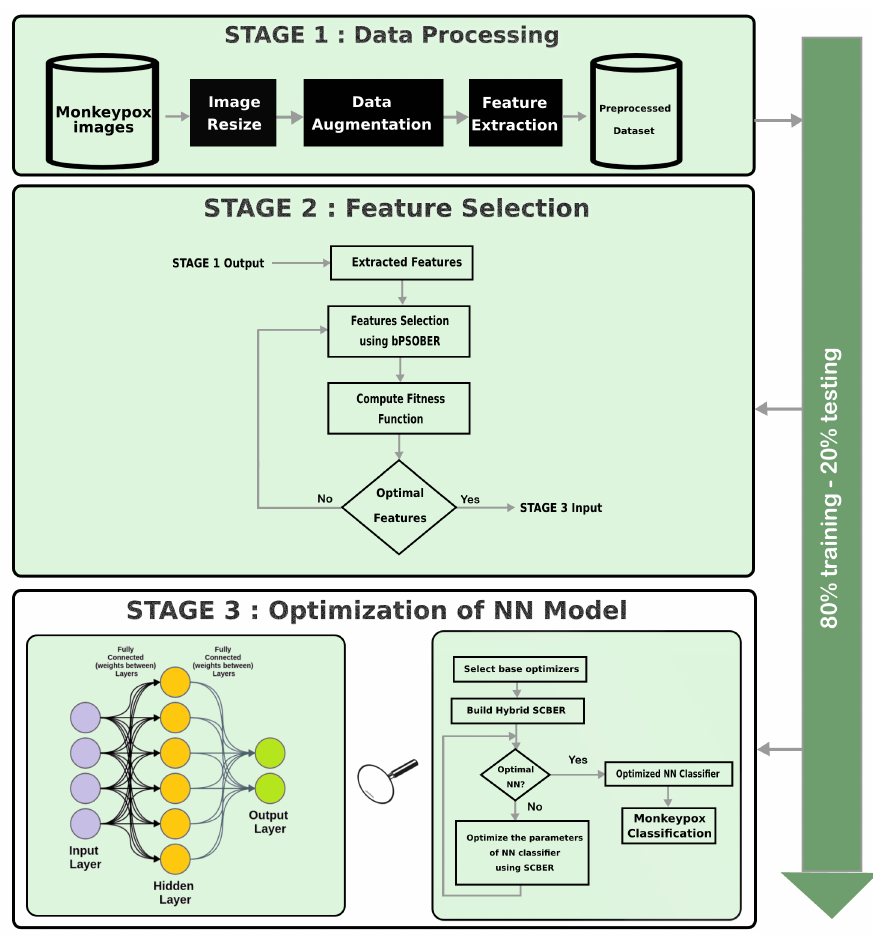
Figure 6. The stages of the proposed monkeypox classification